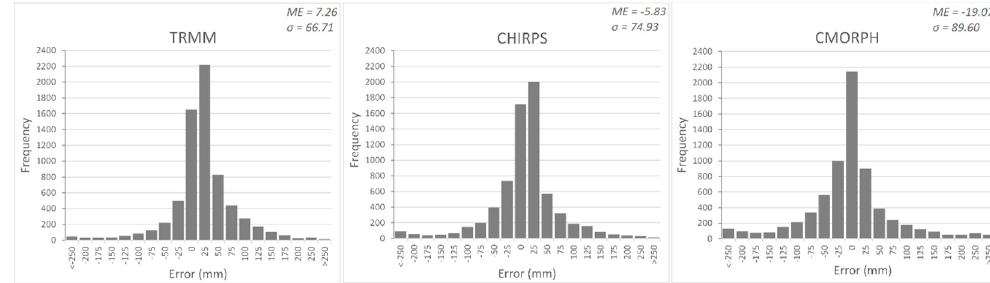
Figure 5. Frequency distributions of the error in monthly rainfall. Indicated are the mean error (ME) and standard deviation ( σ ) in mm. Table 2. Other pairwise validation statistics for three satellite products (S) based on all available station records (G) during the overlapping period (January 2003–December 2014).